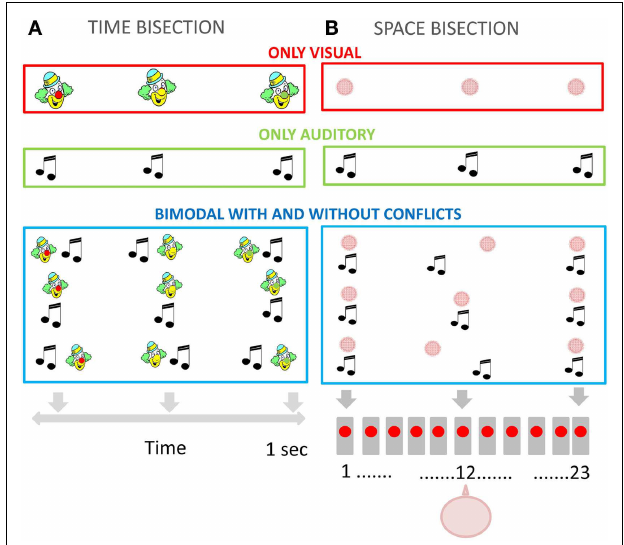
FIGURE 2 | (A) Temporal bisection task. Representation of the visual stimulation (upper panel), auditory stimulation (middle panel), and bimodal conflictual and not conflictual visual-auditory stimulation (bottom panel). (B) Spatial bisection task. Representation of the visual stimulation (upper panel), auditory stimulation (middle panel), and bimodal conflictual and not conflictual visual-auditory stimulation (bottom panel).The subject was aligned with the speaker in the middle (number